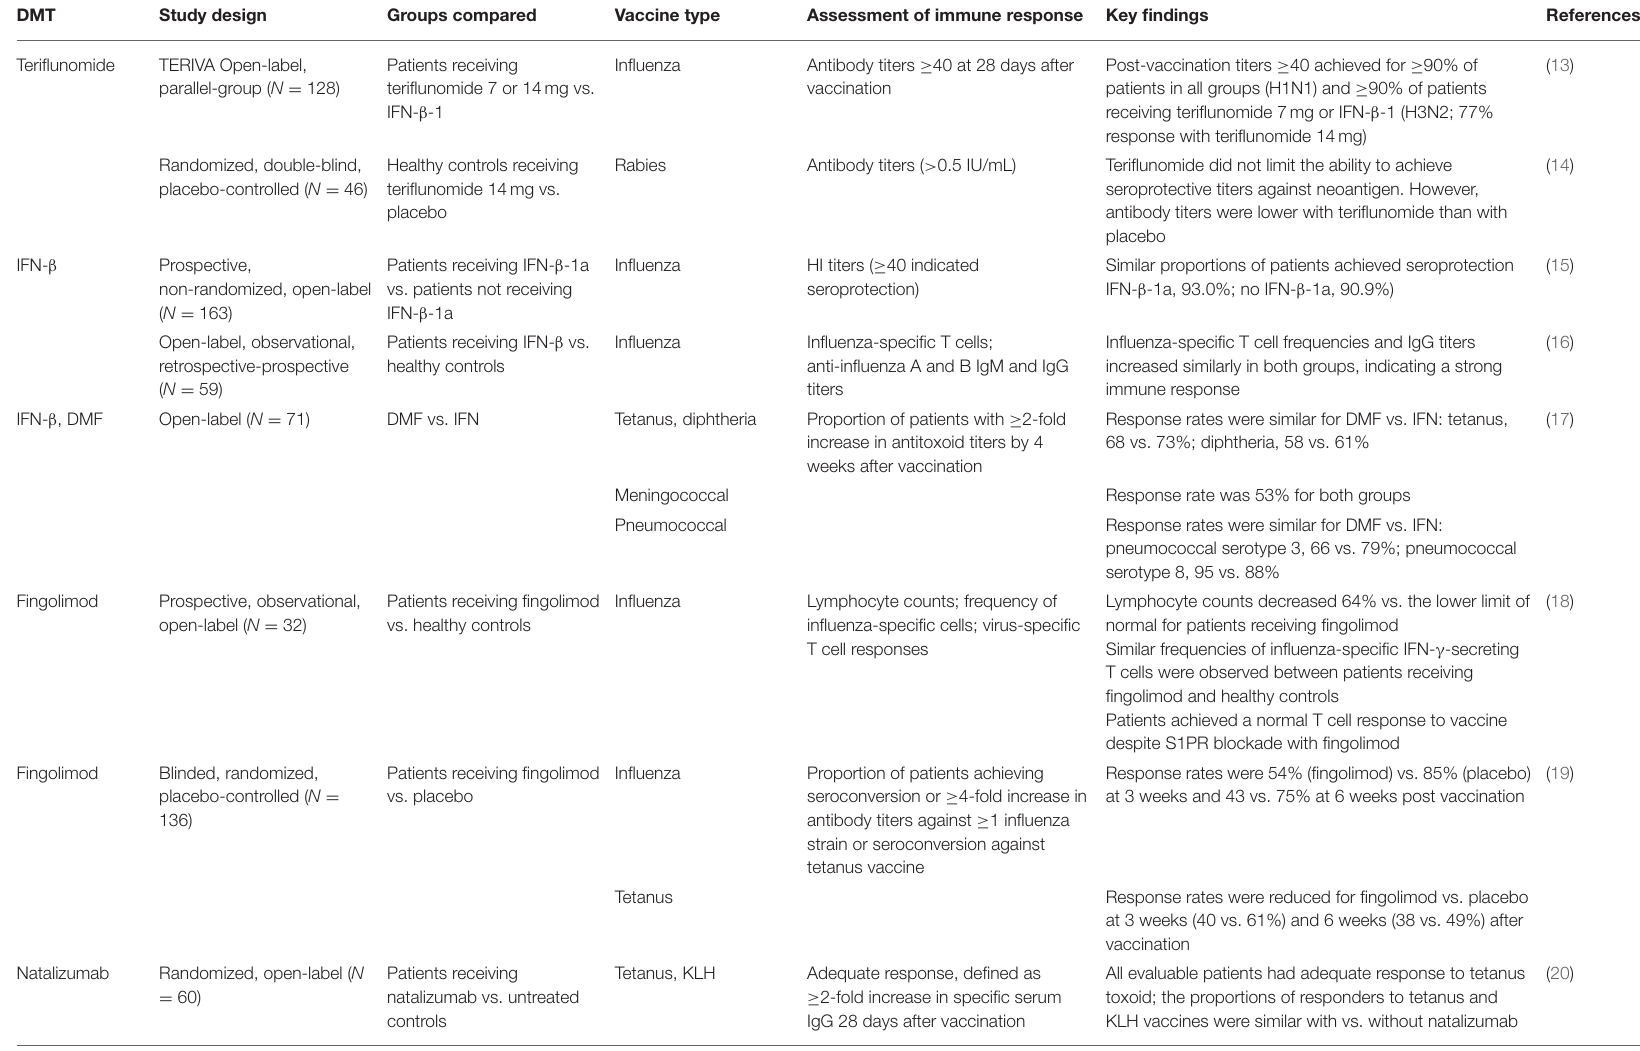
TABLE 1 | Assessed responses to selected vaccines in patients receiving